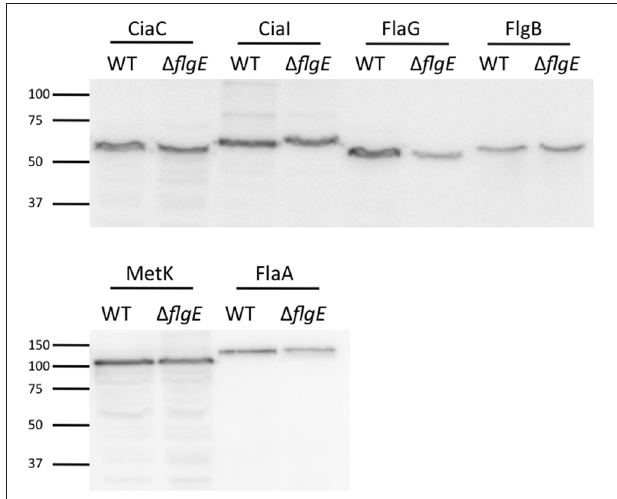
FIGURE 5 | Immunoblot using anti-ACD antibody reveals equivalent protein synthesis of ACD fusion proteins in C. jejuni F38011 wild-type strain and flgE mutant. The amount of ACD fusion proteins produced in the C. jejuni F38011 wild-type strain and isogenic flgE mutant was examined by immunoblot. Whole cell lysates were prepared from bacteria grown overnight in MH broth supplemented with 0.01% deoxycholate, transferred to PVDF membranes, and probed with an anti-ACD antibody. The molecular mass of the pre-stained protein standards are listed in kDa.